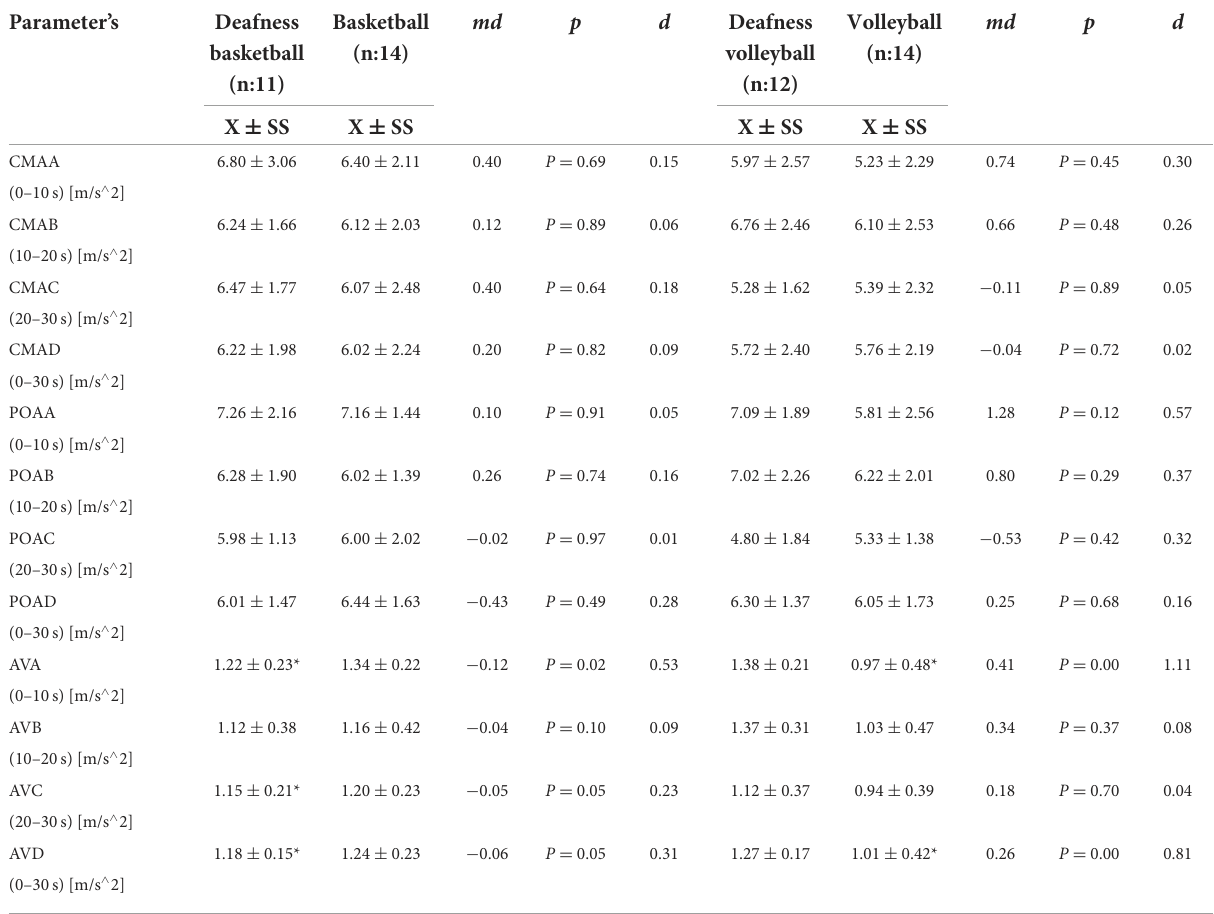
TABLE 2 Comparison of counter movement acceleration, push off acceleration and average velocity of deaf and non-deaf basketball/volleyball players.